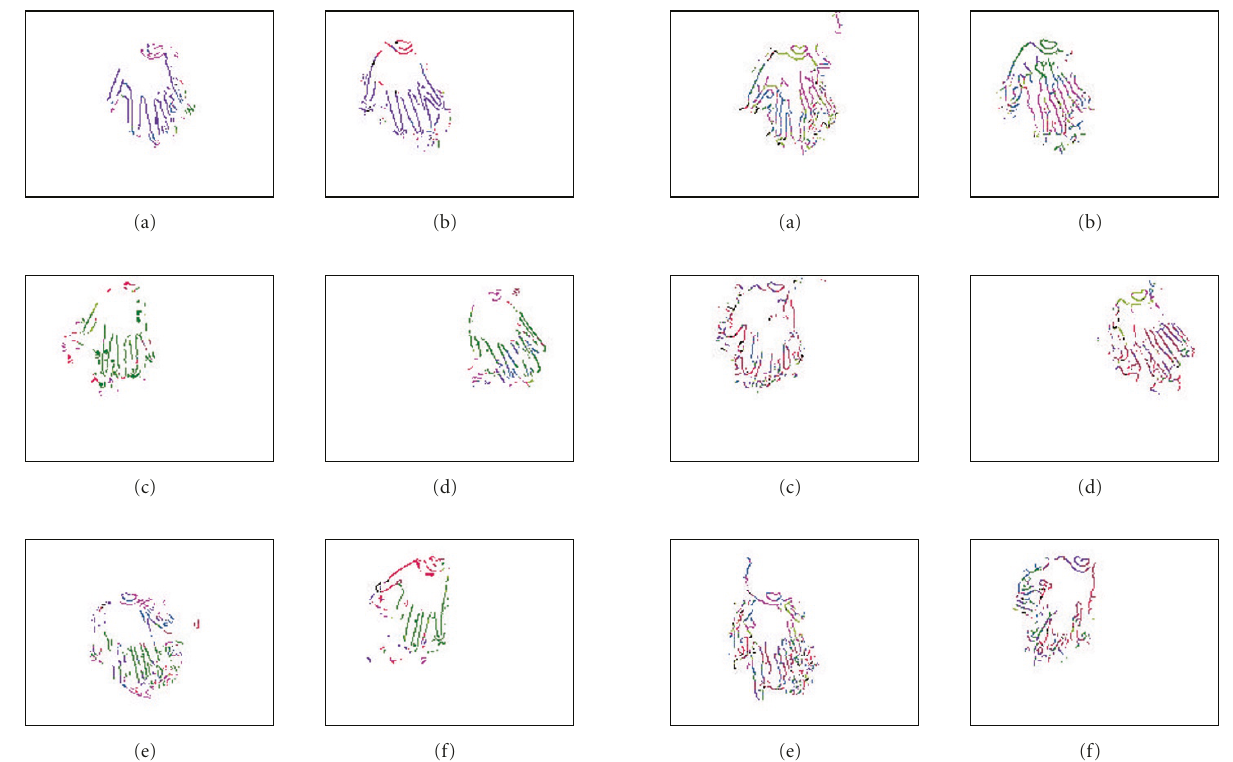
Figure 9: Color-coded motion directions detected by our algorithm for hand sequence at t = 16,29,37,53,66,78. (See Figure 16 for the images.)